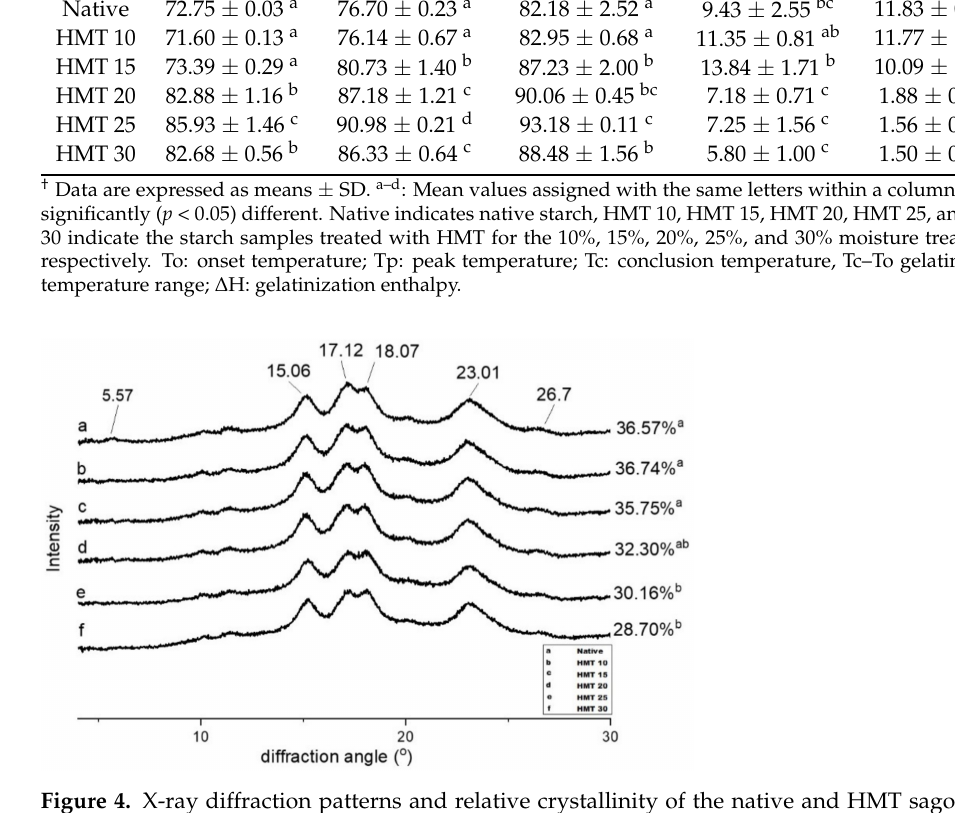
Figure 4. X-ray diffraction patterns and relative crystallinity of the native and HMT sago starch samples. ( a – f ) indicate native, HMT 10, HMT 15, HMT 20, HMT 25, and HMT 30,